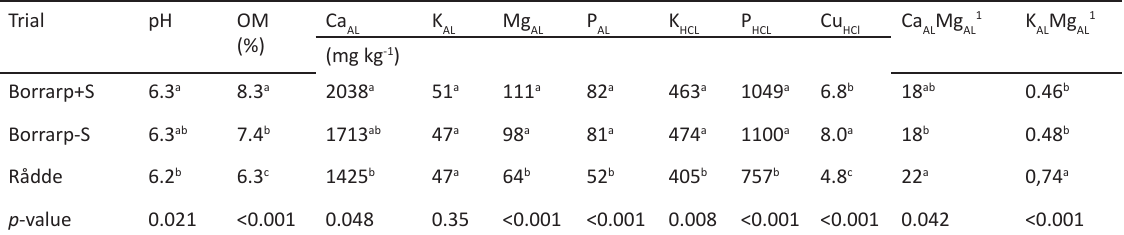
Table 2. Differences between trials in soil conditions, pH, organic matter (OM), extractable element concentrations (mg kg -1 ) and Ca :Mg and K :Mg ratio in the plots after harvest. LSMEANS with different superscripts within columns are significantly different. AL AL AL AL Trial pH OM (%) (mg kg -1 ) Borrarp+S